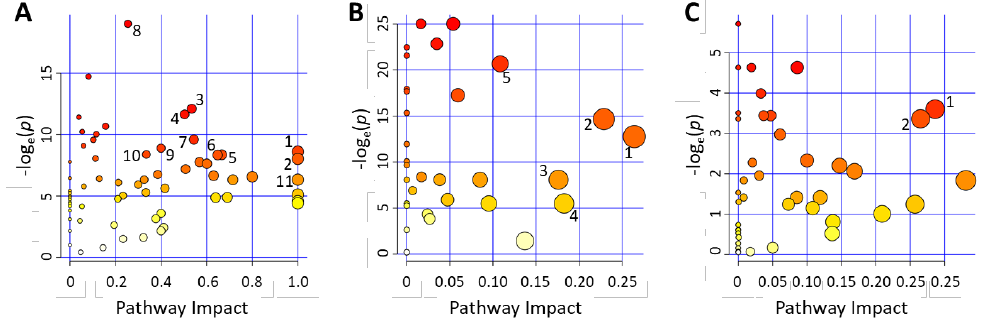
Figure 7. Pathway-impact analysis showing the metabolic pathways ( A ) most affected by onset of T1D in NOD mice; ( B ) associated with metabolites enriched in the aqueous humor versus plasma; and ( C ) associated with metabolites showing equal distribution in both compartments of nondiabetic mice. The shown pairwise comparisons highlight the most impacted pathways (numbered) with an Impact Factor >0.1 as identified by metabolites showing significant pathway enrichment (see Figure 4) with a corresponding p value <0.05 (i.e., −log e ( p ) >2.99) in quantitative enrichment tests (Global-test and Global-Ancova) performed by MetaboAnalyst. The plots in each panel are scaled independently based on the number of metabolites (see above). Color gradient corresponds to the −log e ( p ) value with red being the highest, and symbol size is proportional to the predicted impact factor. Numbered